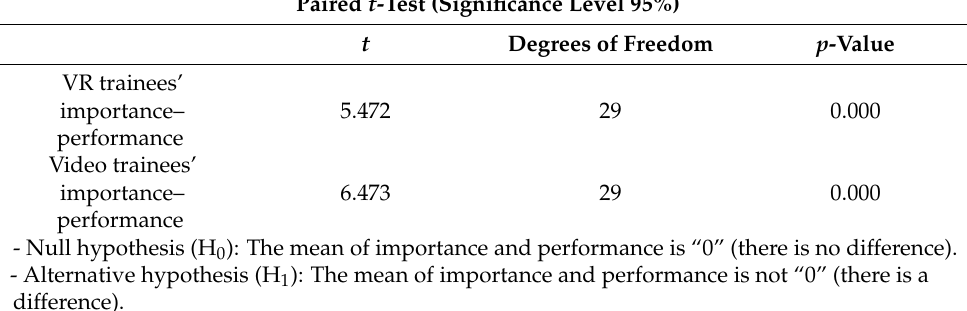
Table 3. Result of t